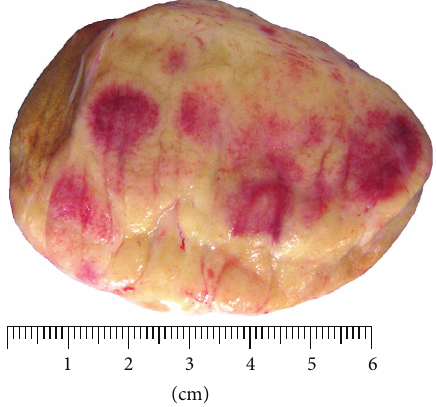
Figure 1: Myeloid sarcoma of the testicle with cut surface appearing as white/tan homogenous tumor with